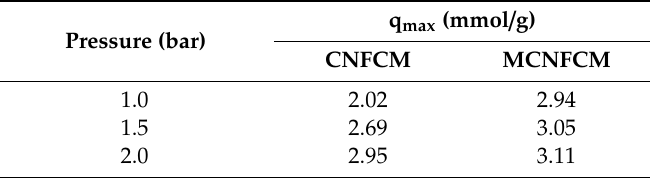
Table 11. CO 2 adsorption over di ff erent pressures. Figure 14. Breakthrough curve and effect of pressure ( a ) CNFCM and ( b ) modified CNFCM in constant T = 30 ° C, Flow = 50 mL/min, and 10% CO 2.